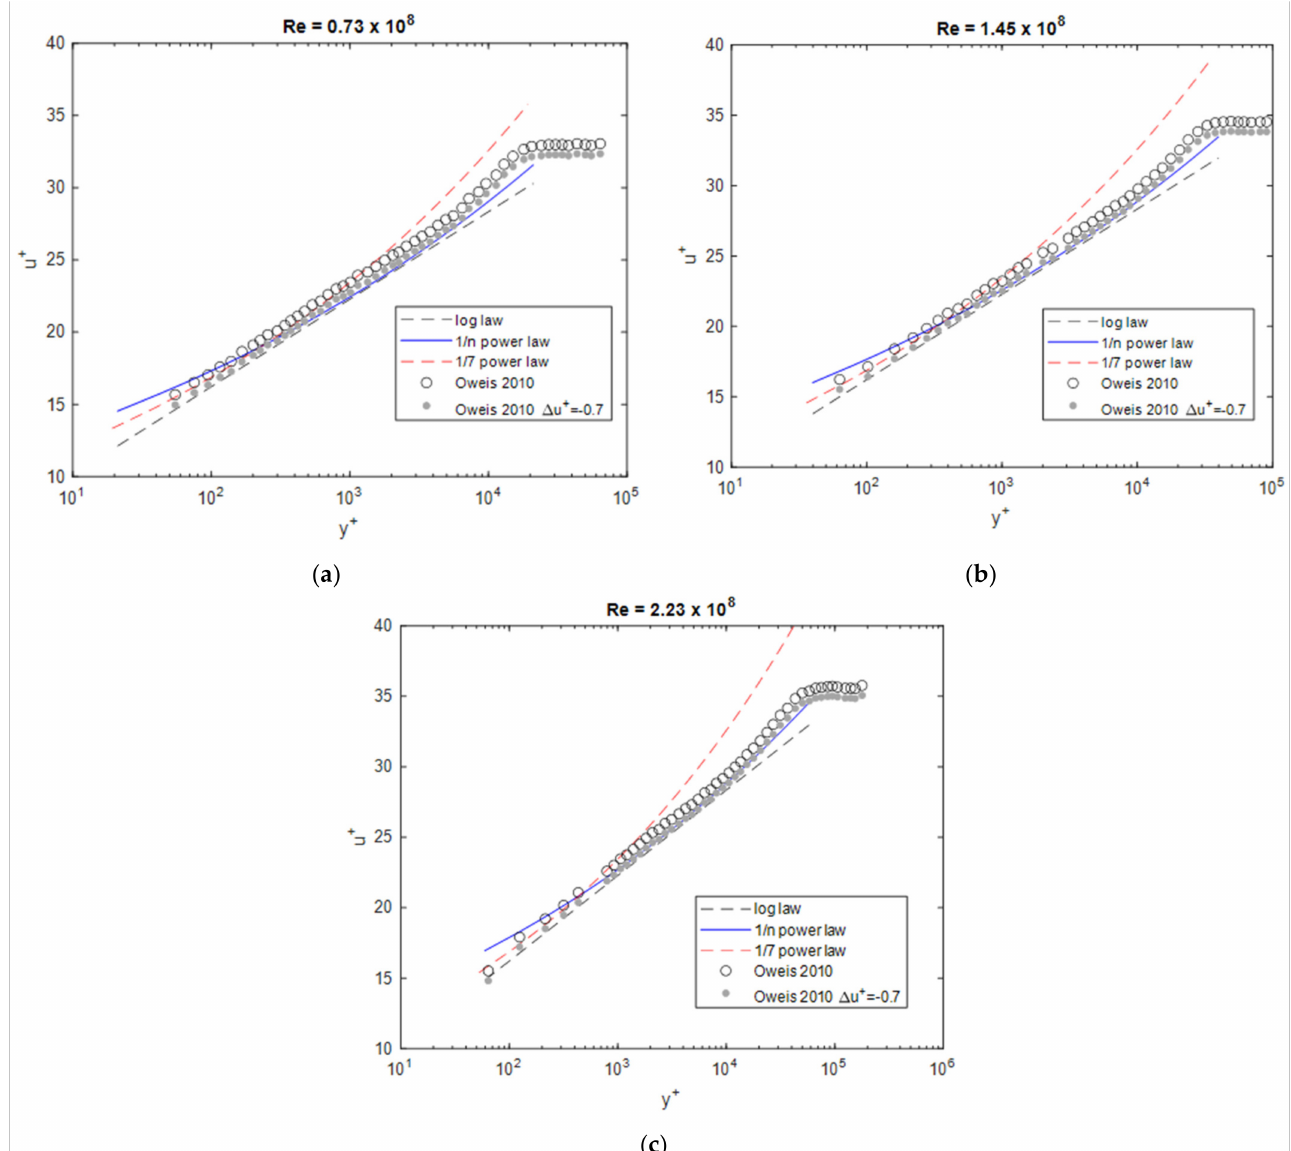
Figure 9. Boundary layer profiles at different Reynolds numbers Re x compared to the data from Oweis et al. [14], ( a ) Re = 0.73 × 10 8 , ( b ) Re = 1.45 × 10 8 , ( c ) Re = 2.23 × 10 8